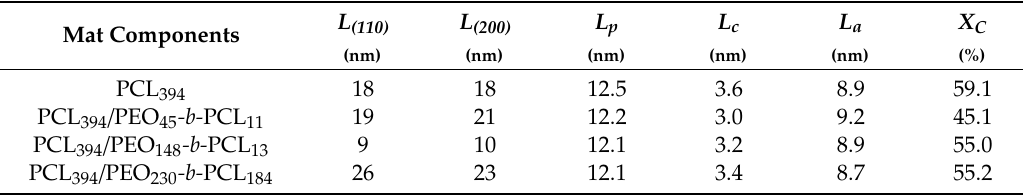
Table 1. Characteristic lengths of crystalline and amorphous domains measured by X-ray diffraction (XRD) and small angle X-ray scattering (SAXS).